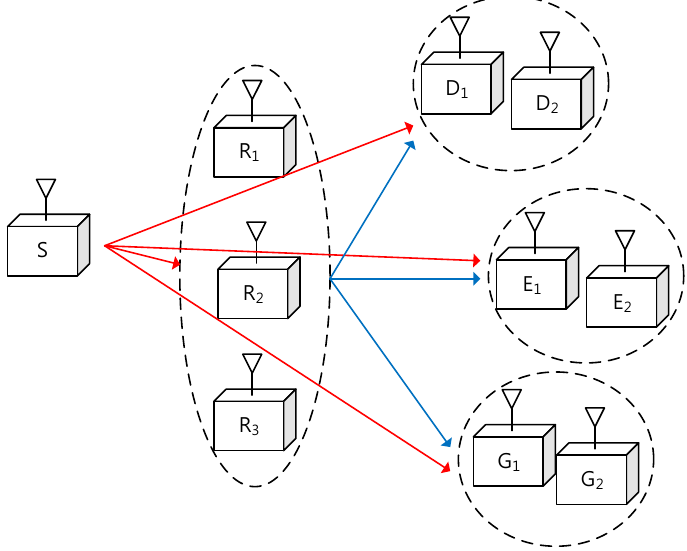
Figure 1. System model for simultaneous wireless power transfer and secure multicasting via cooperative relays ( M = 3 and I = J = K = 2), where S , R m , D i , E j , and G k represent the source, the m th relay, the i th destination, the j th eavesdropper, and the k th energy receiver,